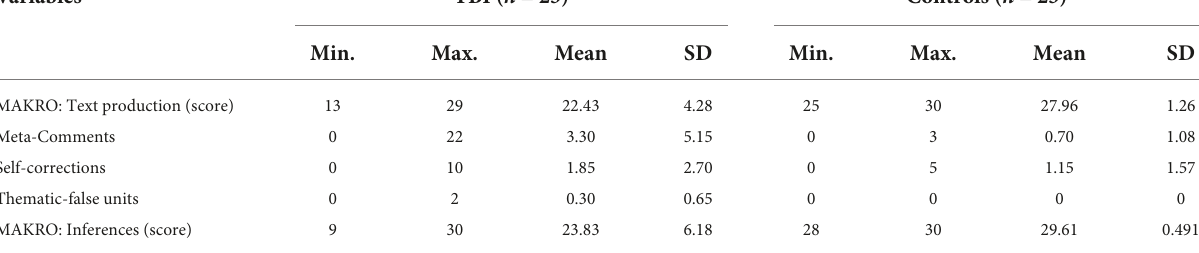
TABLE 5 Descriptive statistics for performance and errors in the verbal fluency tasks.